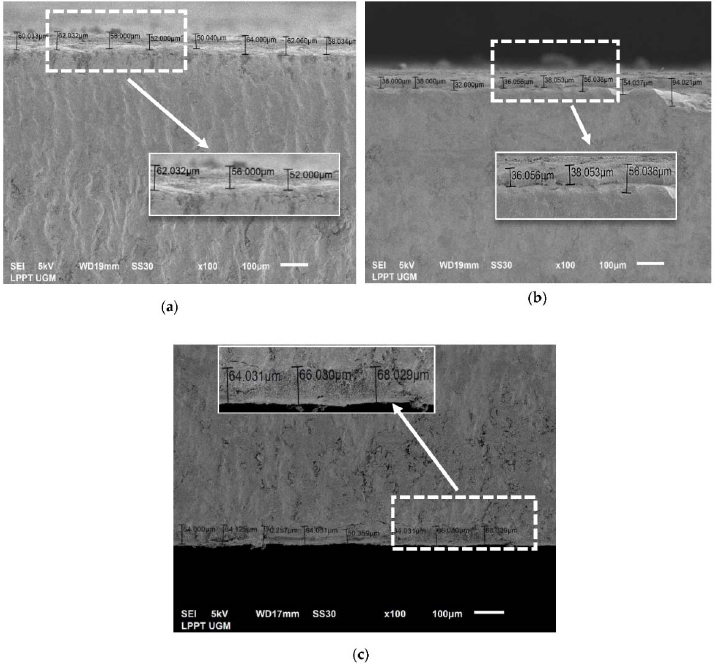
Figure 9. Cross ‐ section of CHA/Ti coating with immersion times of: ( a ) 10 min; ( b ) 20 min; ( c ) 30 min (the white arrow Figure 9. Cross-section of CHA/Ti coating with immersion times of: ( a ) 10 min; ( b ) 20 min; indicates a cross ‐ section of the CHA/Ti coating). ( c ) 30 min (the white arrow indicates a cross-section of the CHA/Ti The immersion time could increase coating thickness, even after a short immersion time of 10 min, as shown in the CHA/HCB/Ti coating (Figure 10 and Table 6). A longer immersion time treatment means the Ti alloy and the CHA and scaffold CHA/HCB sus ‐ pension are longer. It also affected the increase of CHA and scaffold CHA/HCB deposited on the surface, so the thickness also increases. This will cause more and more samples to stick so that the thickness will increase. Based on the data shown in Table 6, the thickness values for all samples were about 41–88 μ m.